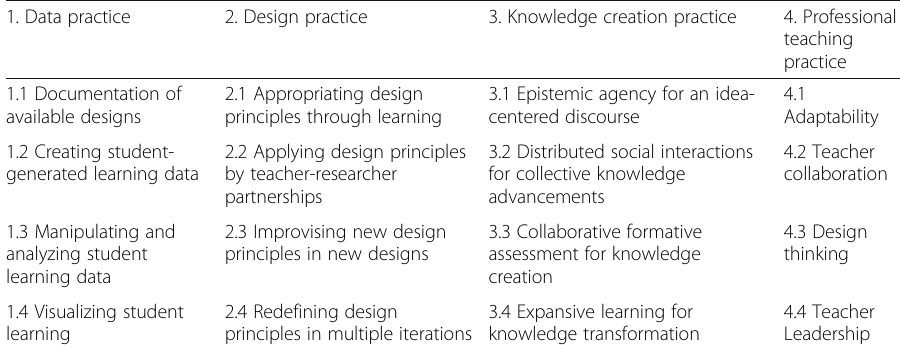
Table 1 Teacher design knowledge (TDK) competency